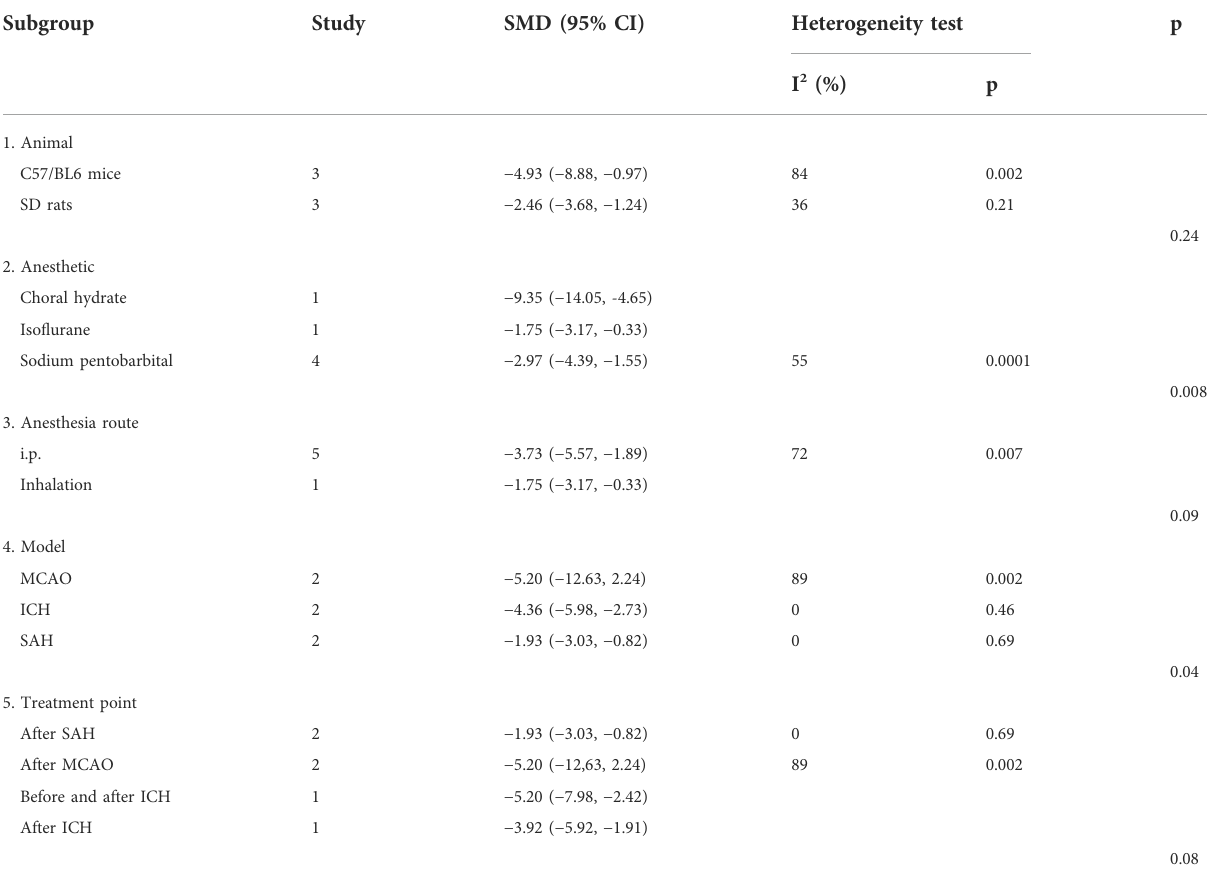
TABLE 4 Strati fi ed meta-analysis of the brain water